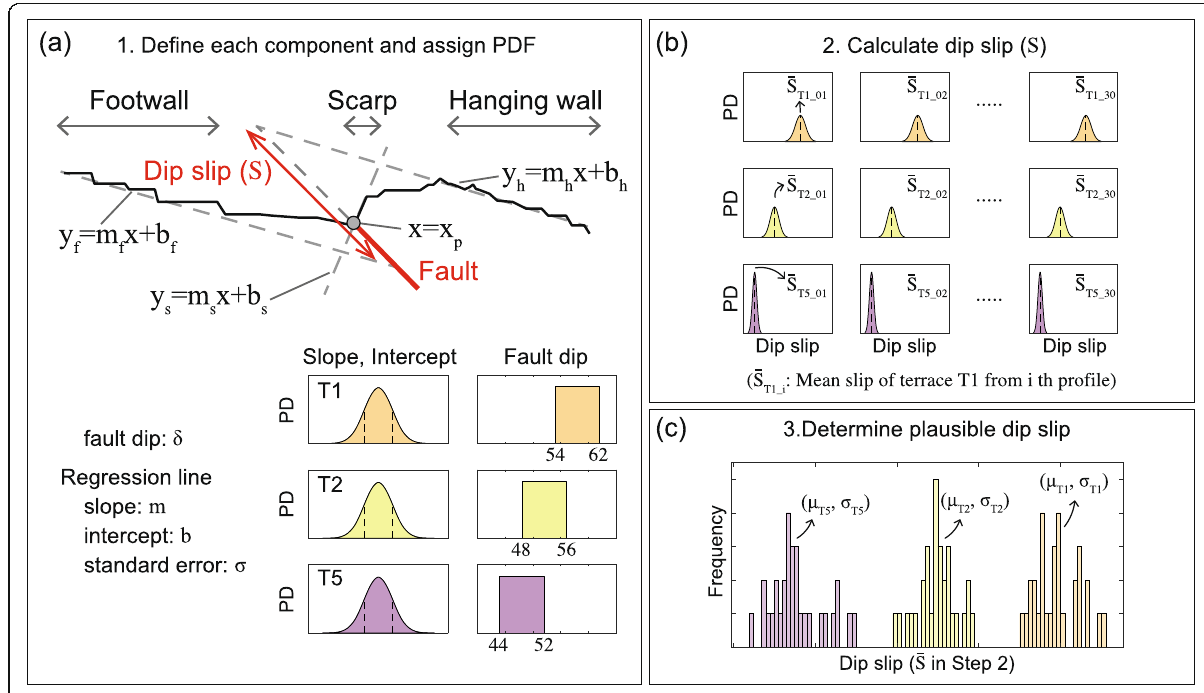
Fig. 5 General steps to calculate dip slip using the MCSST. a Step 1: For each of the 30 profiles on each terrace (Fig. S1), define extents of footwall, hanging wall, and fault scarp on each topographic profile. The fault dip is determined from a ratio of the vertical and horizontal displacement of the 2014 earthquake. The PDF of the fault dip is assumed to be uniform. Slope and interception of topographic profiles (footwall, hanging wall, and fault scarp) are determined from linear regression, and their probability densities are assumed to be normally distributed with mean and standard deviation being the best fit and standard error of the regression. The fault is assumed to intersect with the scarp within the lower 5% of the scarp, and its PDF is uniform. b Step 2: Calculate the dip slip using the PDF defined in step 1. We performed 10,000 realizations for each of the 30 profiles and calculated the mean (denoted as S in the figure). c Step 3: Calculate the mean and standard deviation of (cid:1) S in